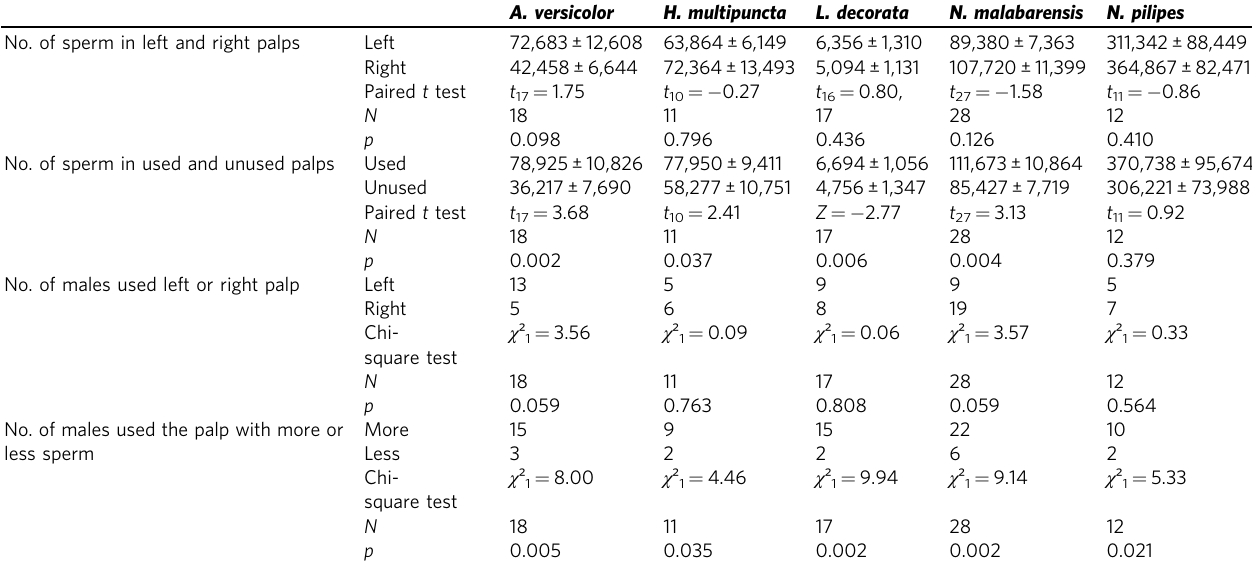
Table 1 Comparisons of the mean (± s.e.m.) number of sperm between the left and right palp, between the used and unused palp for the fi rst insertion, as well as between the number of males that used the left or right palp for the fi rst copulation and between the number of males that used the palp with more or less sperm.